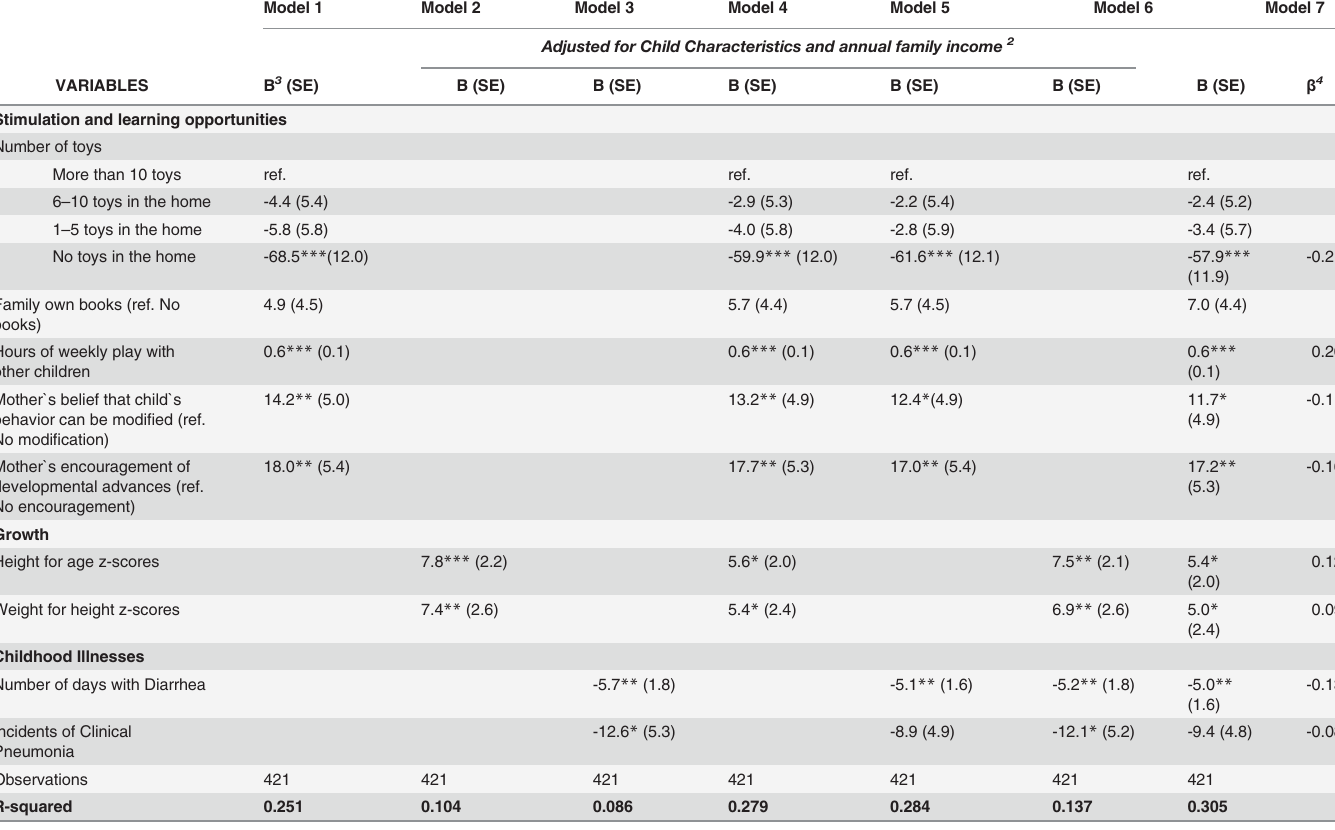
Table 2. Hierarchical Regression Analysis for variables predicting total ASQ-3 scores in North Indian children 12 – 36 months 1